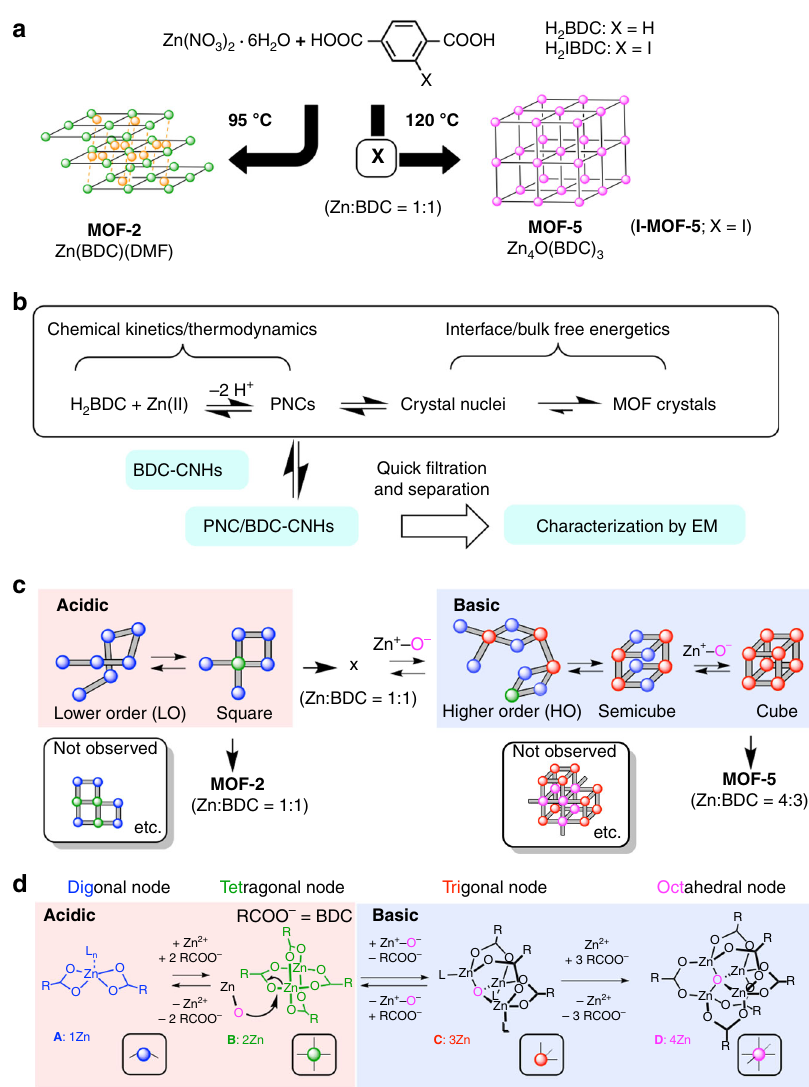
Fig. 1 Formation mechanism of MOF-2 and MOF-5 crystals from Zn 2 + and BDC. a Temperature-dependent bifurcation to MOF-2 and MOF-5 formed from zinc nitrate hexahydrate and H 2 BDC. H 2 IBDC yields isostructural I-MOF-5. See Supplementary Fig. 18 for crystal structure. b Overall pathway of MOF formation that consists of two stages, and capturing of PNCs on BDC-CNHs. c Schematic illustration of the reaction paths from LO PNCs to cube PNCs, and to MOF-2 and -5 crystals. d Structures of nodes consisting of Zn 2 + and